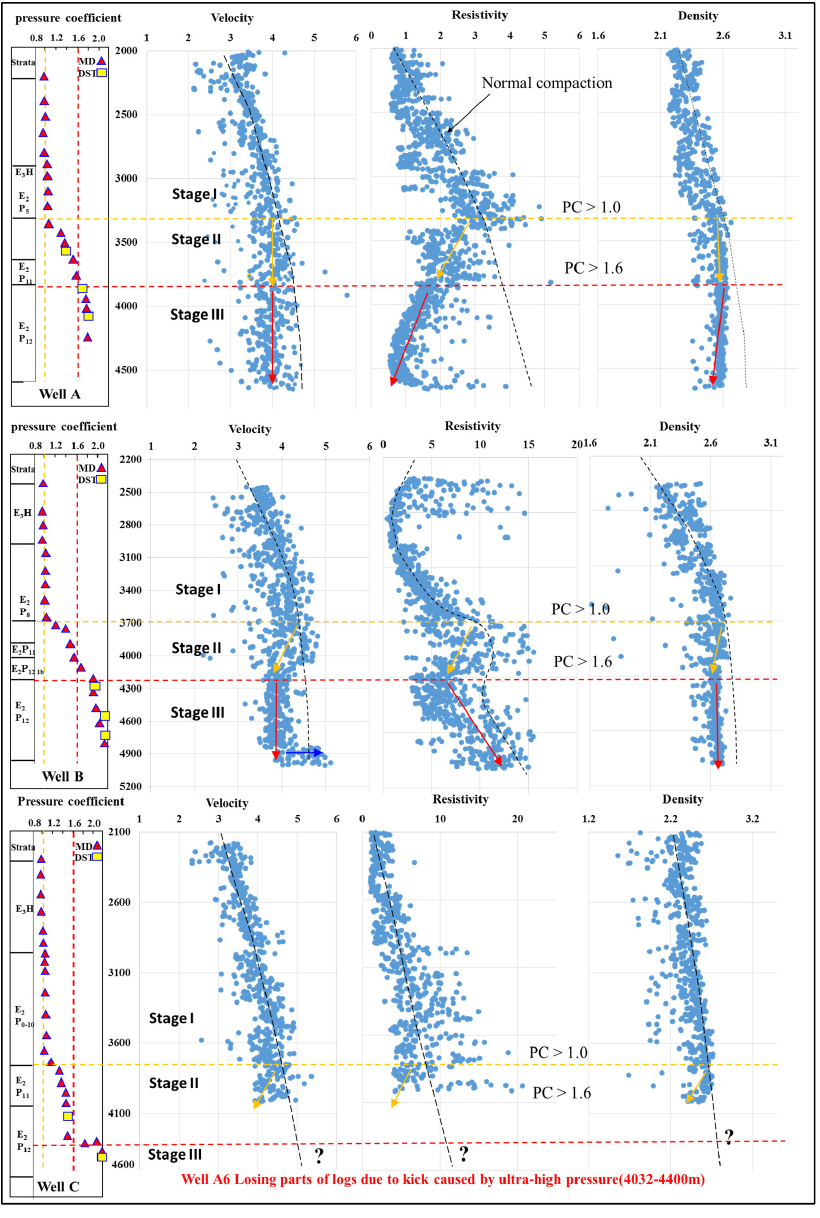
Figure 7. Depth profiles of well-logging parameters, including velocity, density, resistivity, mud weight (MD), and drill stem test (DST) data from Well A, Well B, and Well